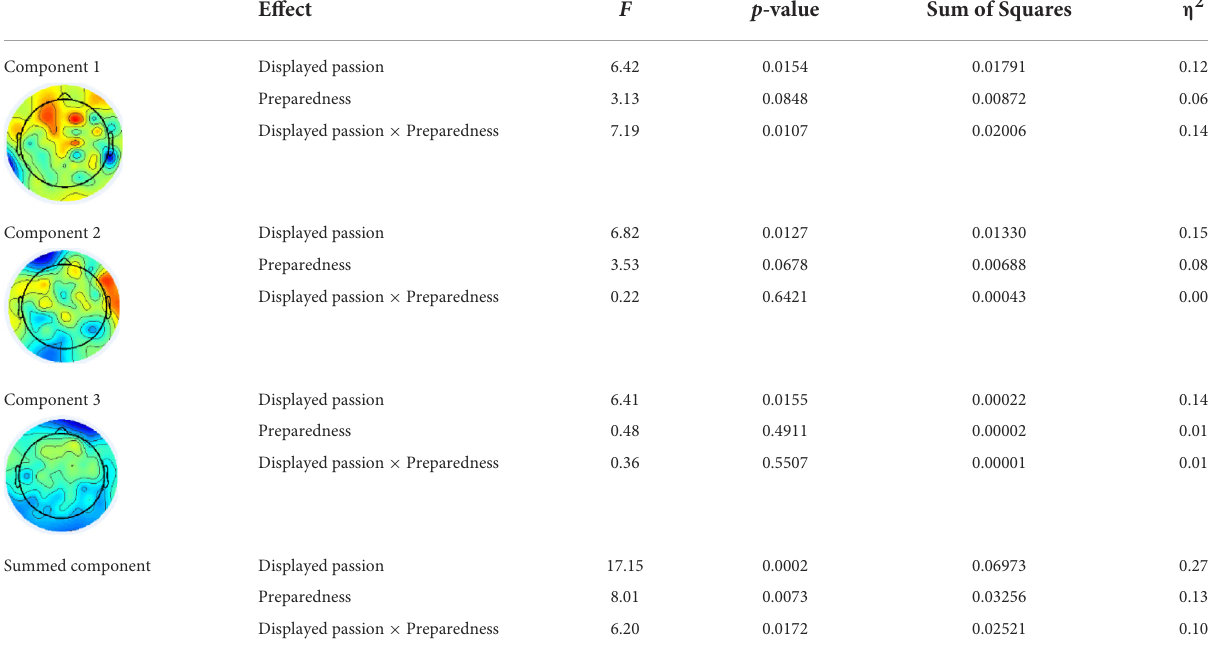
TABLE 1 Results of two-way ANOVA comparing brain coupling during different dimensions. Effect F p -value Sum of Squares η